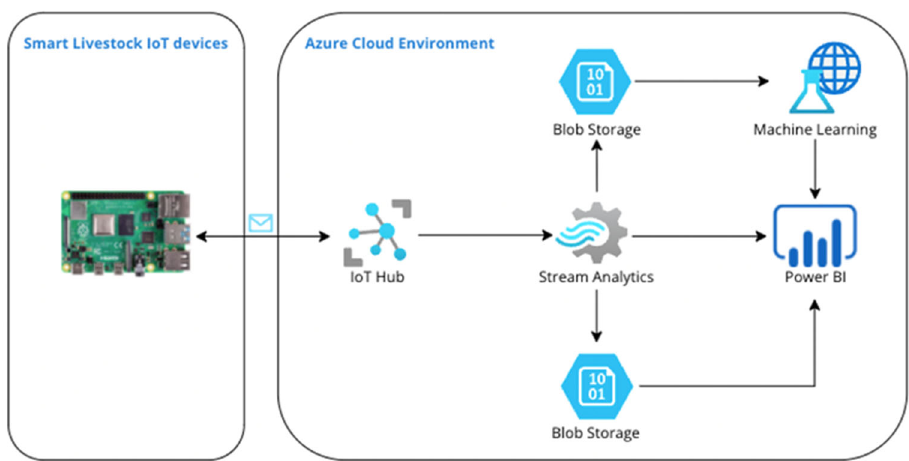
Figure 6. Smart Livestock system architecture.